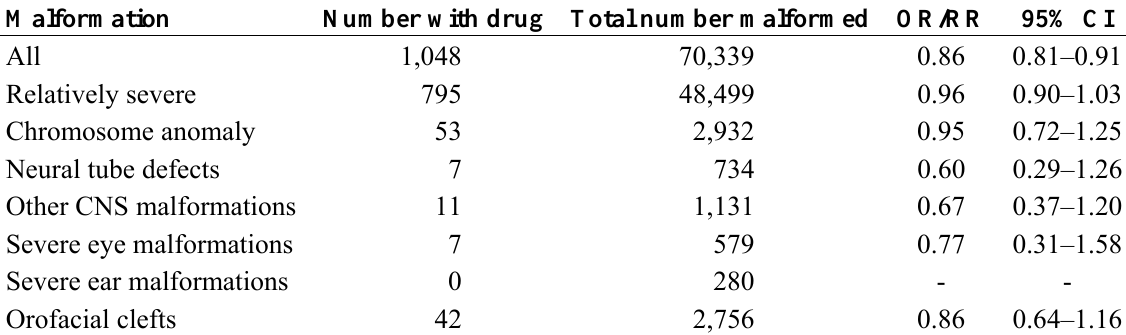
Table 34. Congenital malformations in infants whose mothers used antidepressants in early